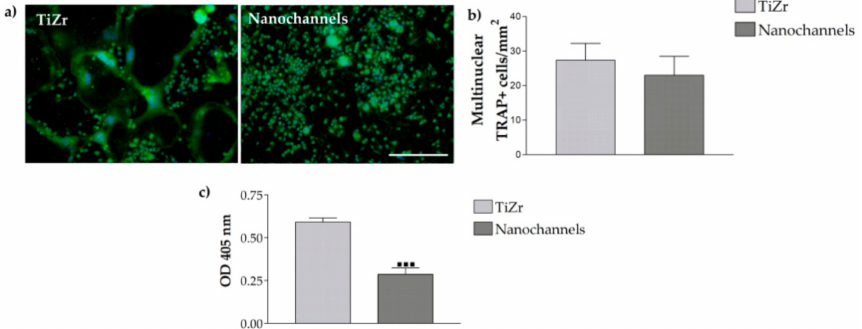
Figure 7. ( a ) Immunofluorescence staining of tartrate-resistant acid phosphatase (TRAP) (green fluorescence: TRAP signals, blue fluorescence: cell nuclei). RAW 264.7 cells were cultured for 7 days either on flat substrate or nanochannels with nuclear factor kappa-B ligand (RANKL) supplementation to the culture media. Scale bar represents 200 µ m. ( b ) The average number of osteoclasts per mm 2 ; ( c ) Intracellular TRAP enzyme activity. Results are presented as means ± SEM ( n = 3); p <